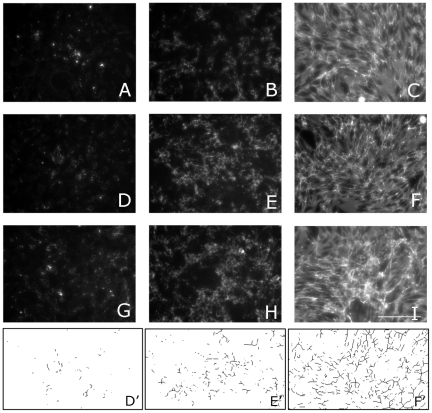
Assessment of Fn matrix assembly by immunofluorescence.Fn matrix assembly by clones expressing low (A–C), High (D–F), and very high (G–I) levels of α5β1 integrin. Clones expressing different levels α5β1 receptor were plated at a density of 5×105 cell/ml. Fibronectin immunostaining was carried out after 2 days in Fn-depleted tissue culture medium (A, D, G) or medium containing 30 µg/ml (B, E, H) or 300 µg/ml (C, F, I) soluble fibronectin. The assembled matrix becomes qualitatively more fibrous as a function of increasing receptor expression and soluble fibronectin concentration. Scale Bar 100 µ.